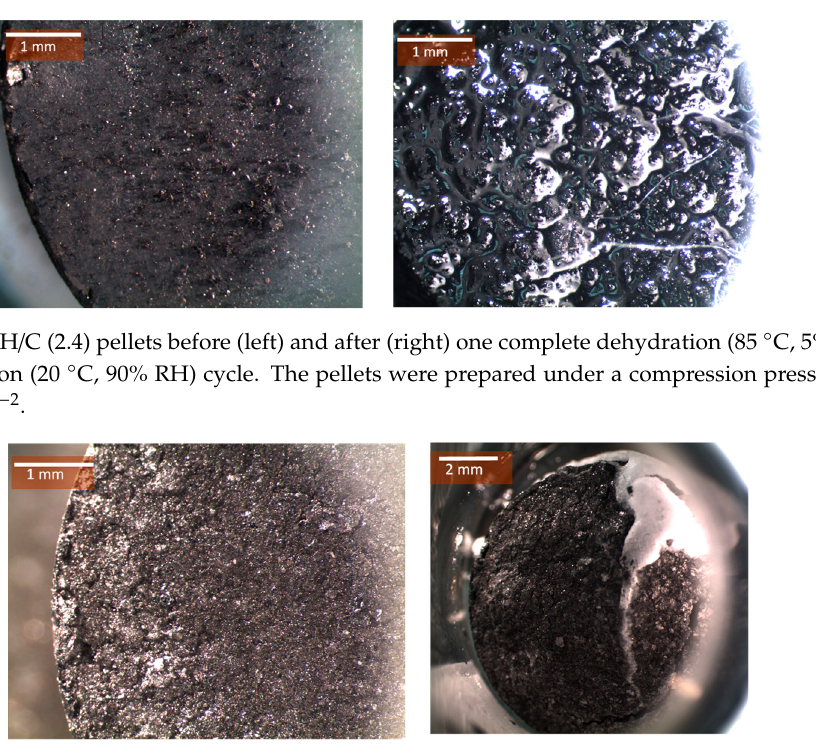
Figure 7. MSH/G (2.4) pellets before (left) and after (right) one complete dehydration (85 °C, 5% RH) and hydration (20 °C, 90% RH) cycle. The pellets were prepared under a compression pressure of 0.77 kN ⋅ mm − 2 .